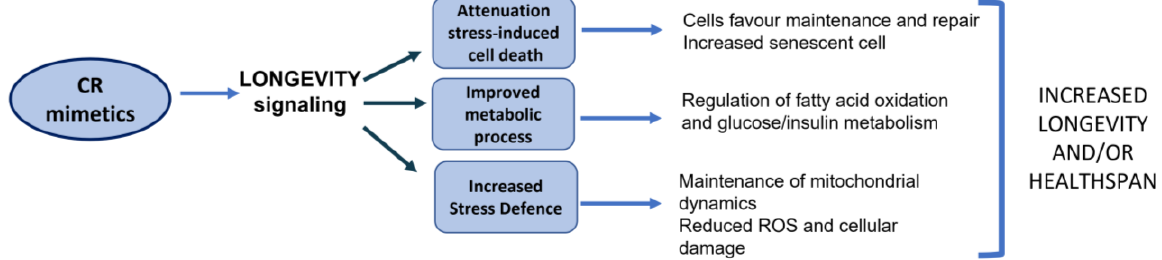
Figure 1. Mechanisms by which CR mimetics restrain the induction and propagation of cellular senescence. CR is a mild stress that provokes a survival response in the organism, which boosts resistance to stress and counteracts the causes of aging. CR mimetics reverse aging-derived effects by igniting numerous cellular mechanisms involved in the improvement of the lifespan. CR: calorie restriction; ROS: reactive oxygen species.